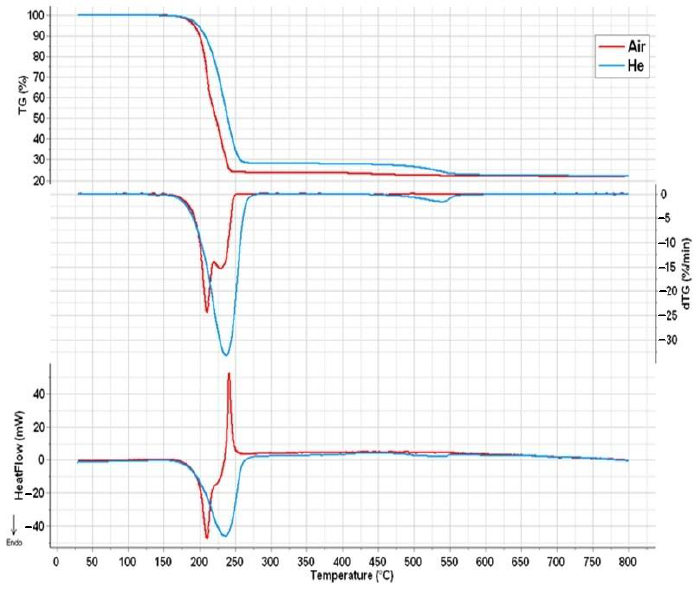
Figure 6. The thermal decomposition characteristics of compound 1 in helium atmosphere and in air.